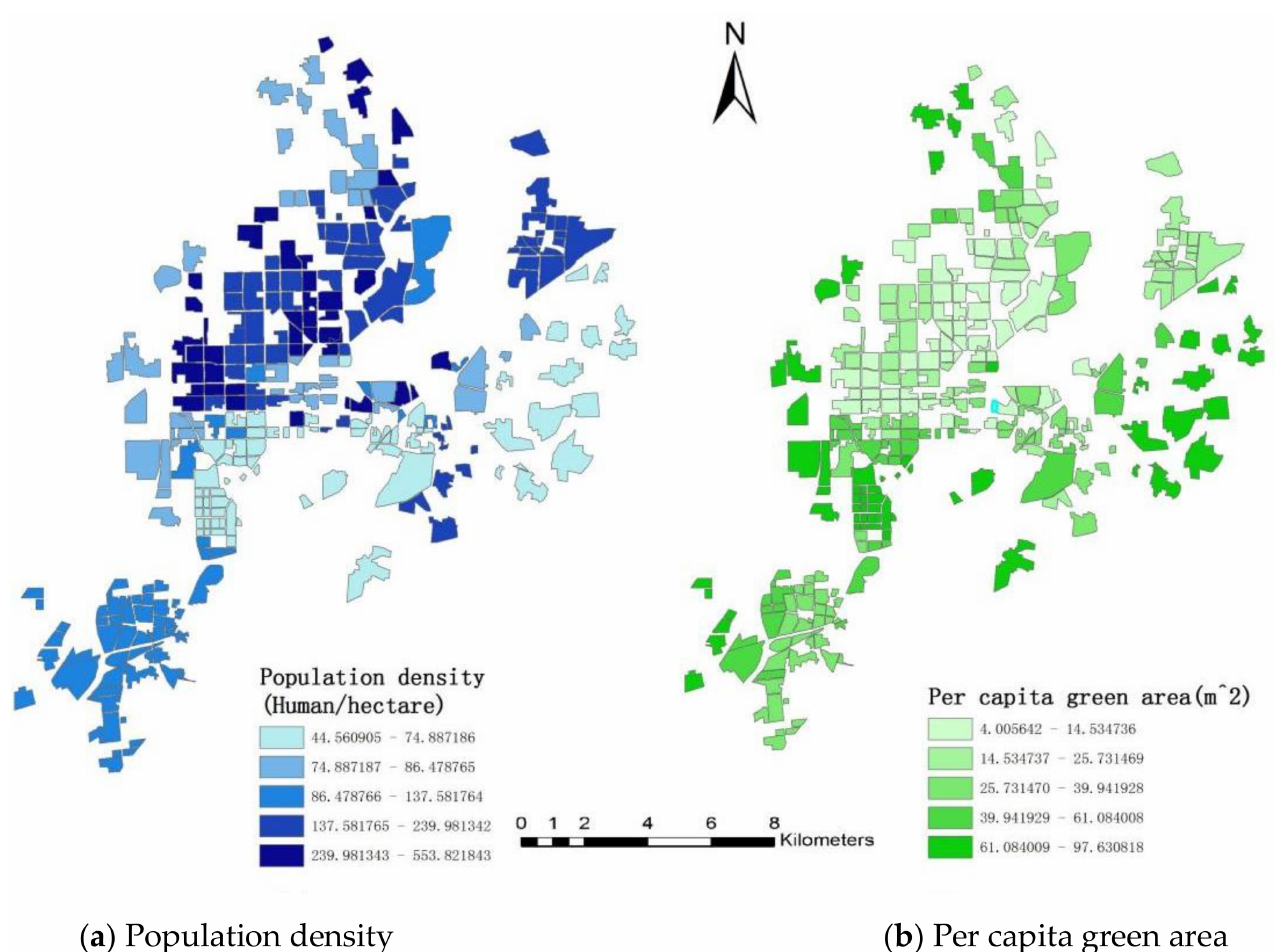
Figure 6. Population density and per capita green